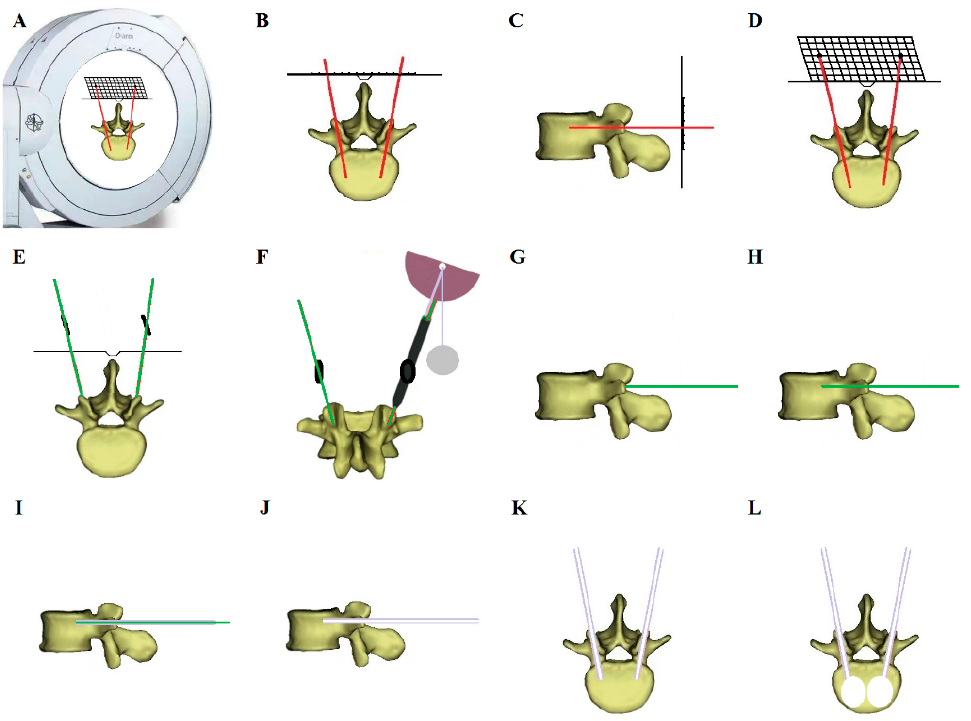
Figure 2. Schematic diagram showing the surgical procedure. ( A ) Three-dimensional CT scans of the fractured vertebral body and body surface locator were carried out using the O-arm. ( B – D ) CT scans were used to reconstruct a 3D image and perform preoperative planning. ( E ) The entry point on the skin was determined using the body surface locator before the operation. ( F ) The intradermal locator was placed along the Kirschner wire, and then the guide device was deflected according to the planned trajectory, which could be observed using the angle-measuring device. ( G – K ) A dilating cannula and a working cannula were inserted to establish the working channel. ( L ) Cement was injected into the vertebra.